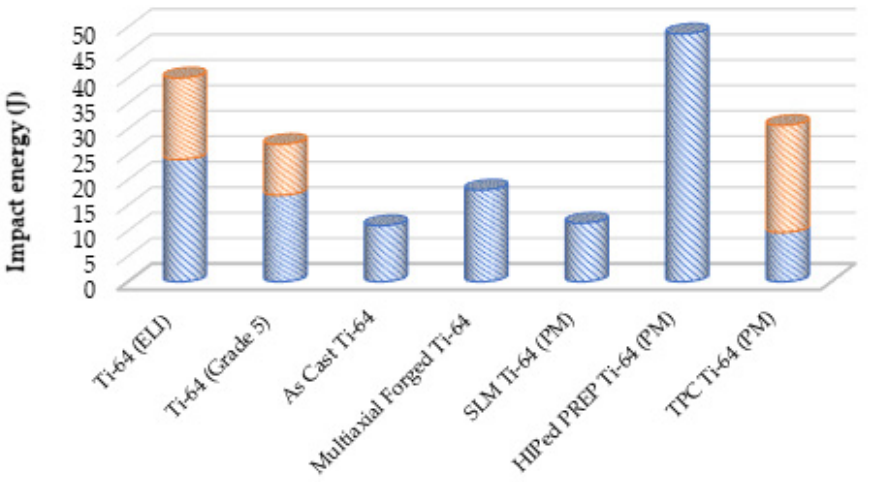
Figure 1. Impact toughness (range) of Ti-6Al-4V alloy produced by various ingot and PM methods [20–32].